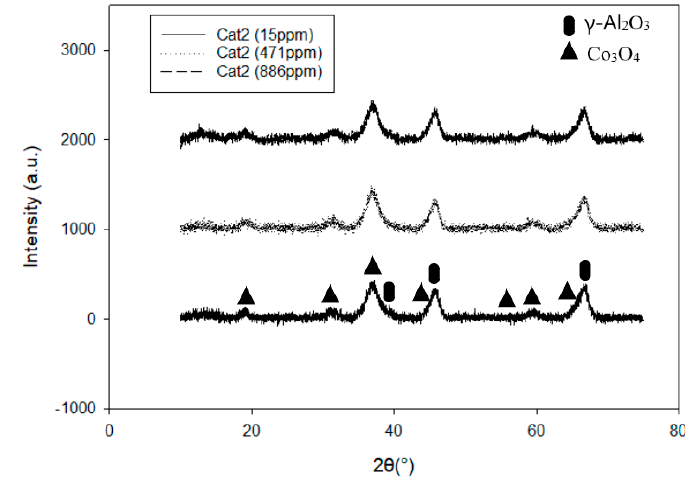
Figure 2. XRD patterns for 20%Co/0.5%Re/ γ -Al 2 O 3 with different K loadings.